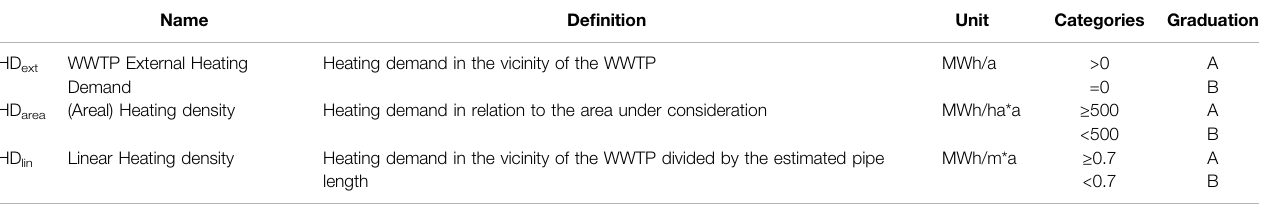
TABLE 2 | Criteria for the spatial pre-assessment (based on ARGE QM Fernwärme, 2021).